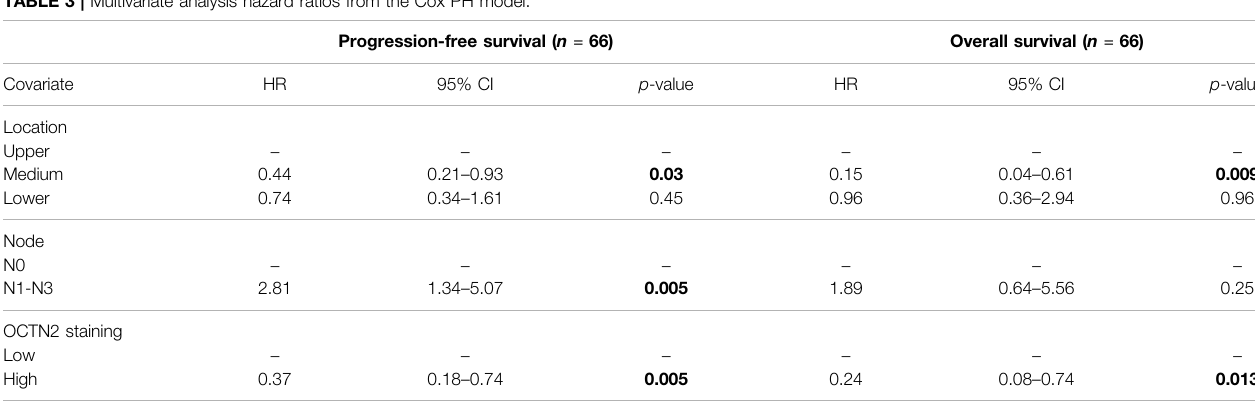
TABLE 3 | Multivariate analysis hazard ratios from the Cox PH